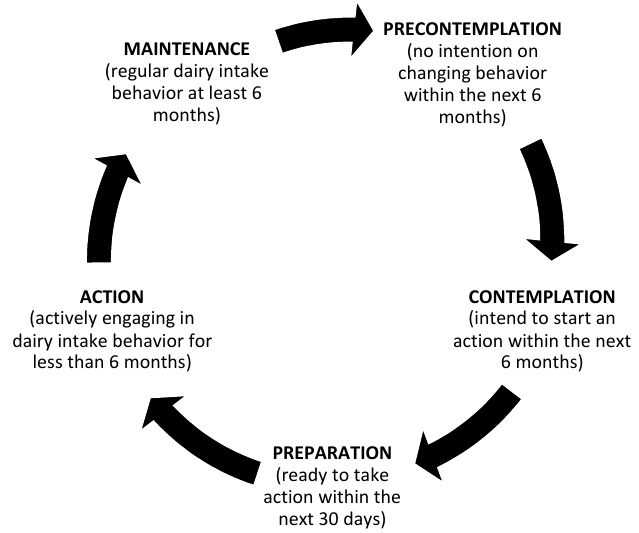
Figure 2. The stages of change in a transtheoretical model.